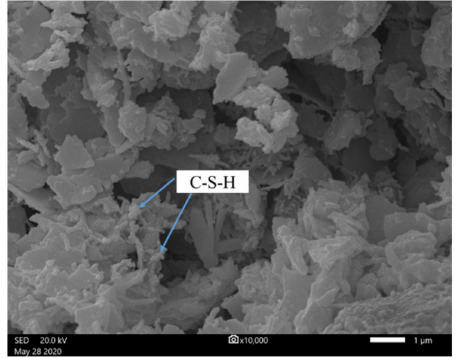
Figure 7. SEM micrograph of CPB with